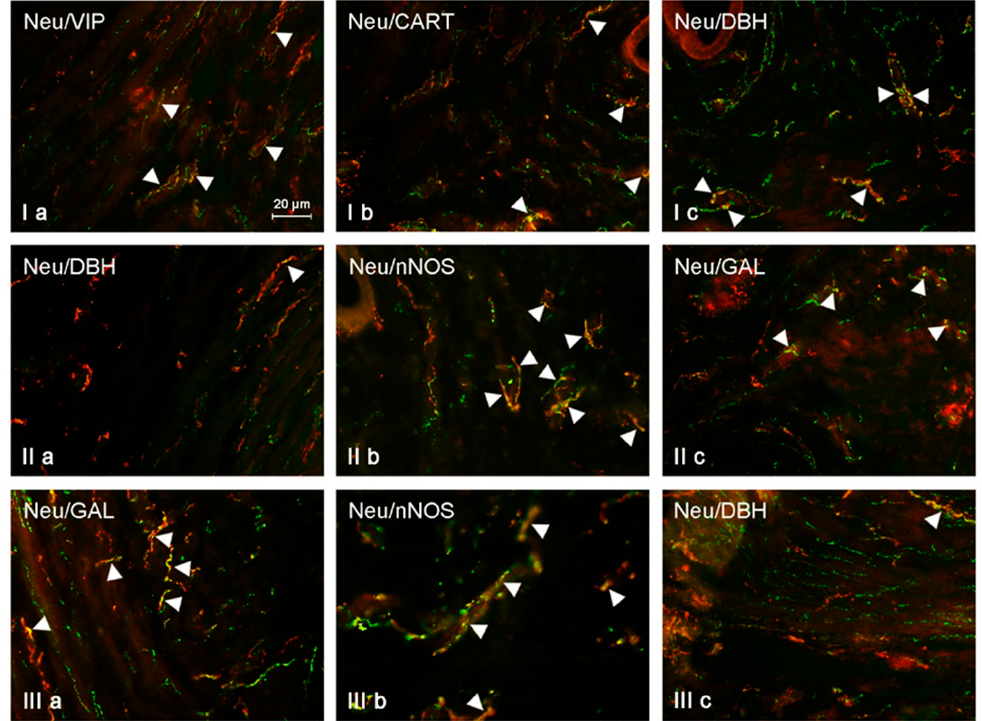
Figure 1. Neuregulin (NRG)-positive nerves (NRG-1+ green) immunoeractive to dopamine beta-hydroxylase (DBH), substance P (SP), vasoactive intestinal polypeptide (VIP), neuronal isoform of nitric oxide synthase (nNOS), galanin (GAL), and cocaine- and amphetamine-regulated transcript (CART) (red) in the muscular layer of the uterine body of control animals ( a ) and pigs treated with low ( b ) and high ( c ) dose of bisphenol A. Nerves simultaneously immunoreactive to NRG-1 and other substances (yellow) are indicated with